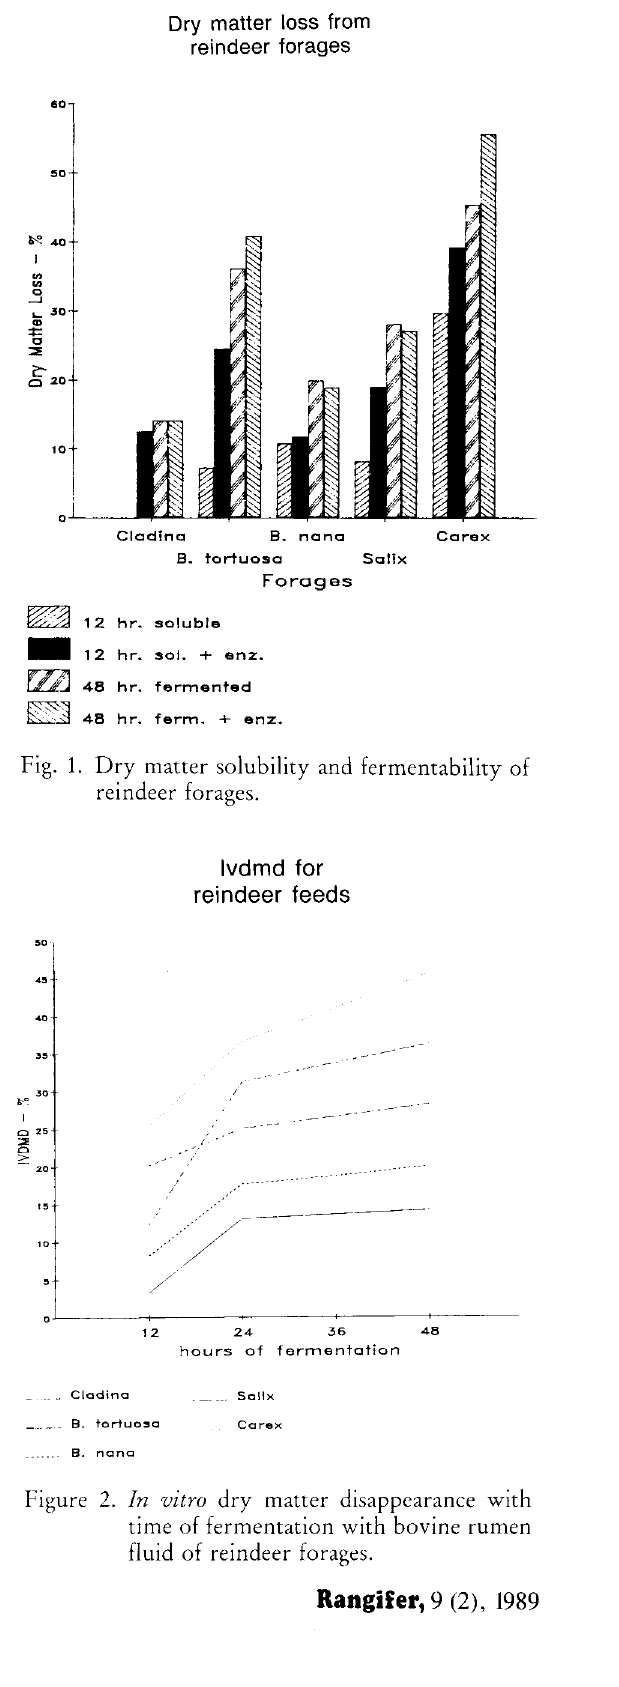
Figure 2. In vitro dry matter disappearance with time of fermentation with bovine rumen fluid of reindeer